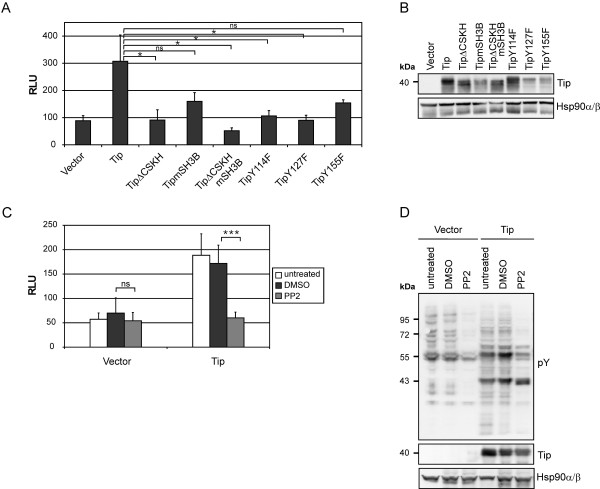
The role of Src-kinase interactions of Tip for SRF activation. (A) Jurkat T cells were transiently transfected with expression plasmids coding for wild-type Tip or its mutants TipΔCSKH, TipmSH3B, TipΔCSKHmSH3, TipY114F, TipY127F and TipY155F. Empty vector (pEF1) served as negative control. Activation of cotransfected p3D.A-Luc displayed as mean values and standard deviation of three independent experiments. Statistical significance, p > 0.05 (ns); p < 0.05 (*). (B) Expression control for Tip and its mutants in total lysates obtained from the cells described in (A). (C) Vector and Tip constructs were cotransfected with p3D.A-Luc into Jurkat T cells, and SFK activity was blocked by PP2 treatment (10 μM) for 40 h. The graph summarizes the reporter activities of six independent experiments. Statistical significance, p > 0.05 (ns); p < 0.001 (***). (D) Total cellular protein tyrosine phosphorylation (pY) and Tip expression in the cells described in (C). Detection of Hsp90α/β served as a loading control